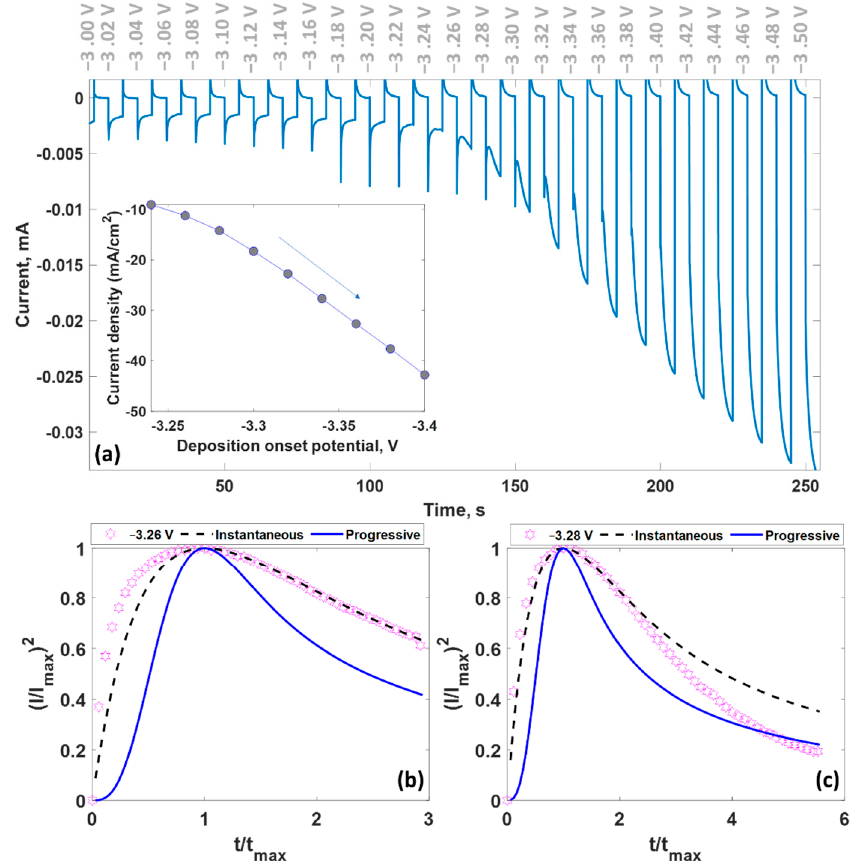
Figure 6. ( a ) Chronoamperometric curve for the electrodeposition of lithium from PC|LiClO 4 elec-trolyte on bilayer-patched epitaxial graphene under potential stepping from − 3 V to − 3.5 V. Inset demonstrates the relationship between the maximum current density and deposition potential. ( b , c ) Comparison of the experimental current transient curves registered at different potentials ( − 3.26 and − 3.28 V) with theoretical modeling for instantaneous and progressive nucleation mechanism.